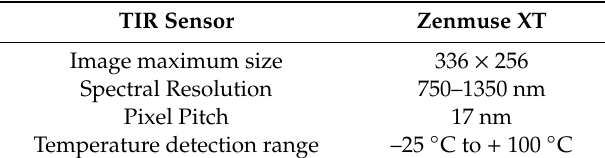
Table 2. Specifications of the thermal-infrared camera.